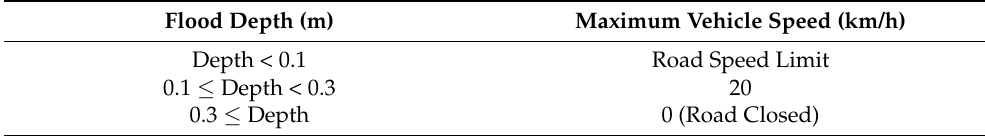
Table 2. Flood depths’ effect on traffic flows.